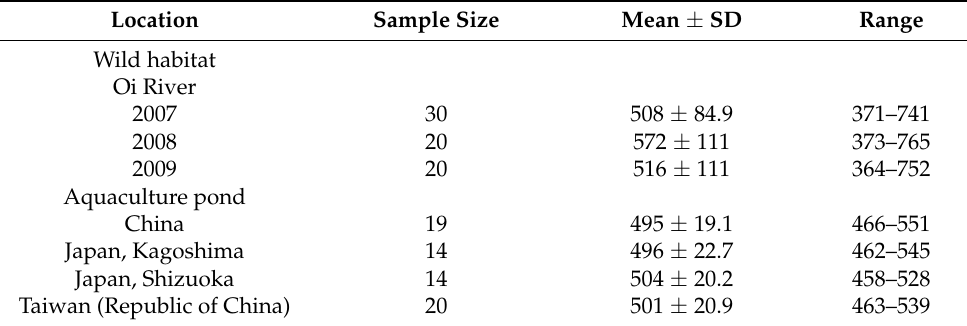
Table 1. Total lengths (mm) of Japanese eel used in this